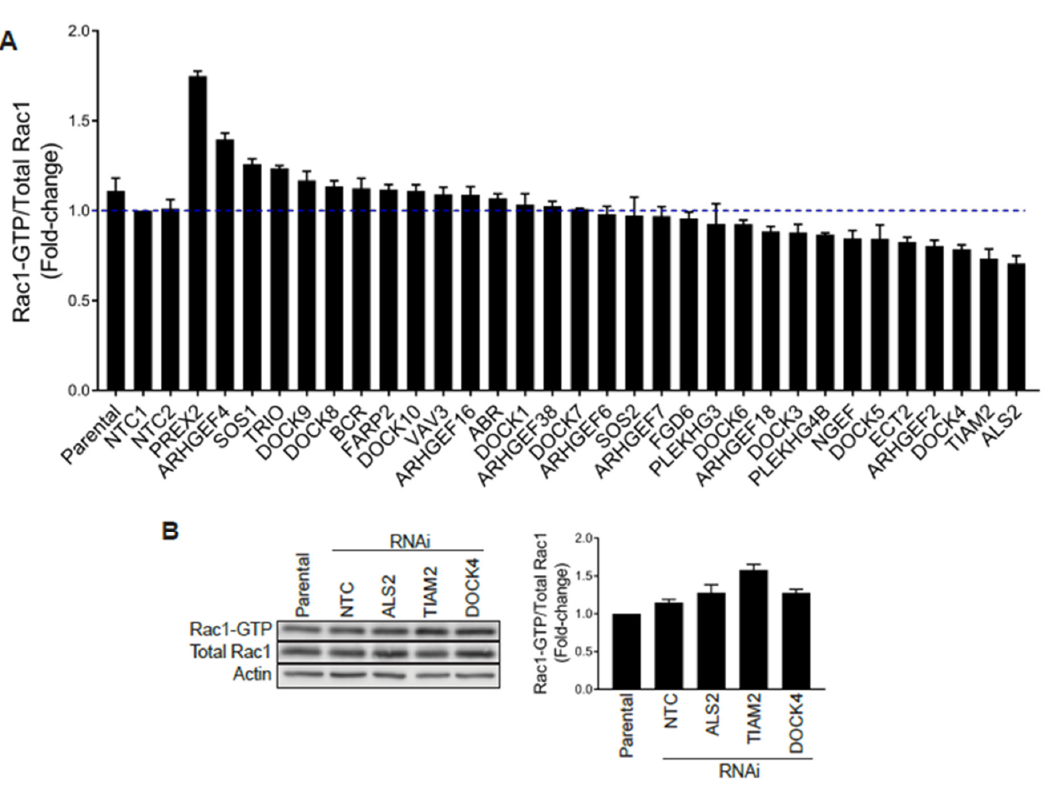
Figure 5. G-LISA screen of Rac-GEFs. ( A ) PC3 cells with stable depletion of indicated Rac-GEFs were serum starved and Rac1-GTP levels analyzed using a G-LISA assay screen. Rac1-GTP levels, normalized to total Rac1 assessed by Western blot and expressed relative to NTC1, are expressed as the mean of three replicates ± S.D. ( B ) PC3 cells were transfected with siRNA duplexes targeting ALS2, TIAM2, DOCK4 or a non-target control ( NTC ), and Rac1-GTP levels measured using a PBD assay after 48 h. Left panel , representative experiment. Right panel , densitometric analysis of Rac1-GTP / total Rac1. Results, relative to parental cells, are expressed as the mean ± S.E. ( n =